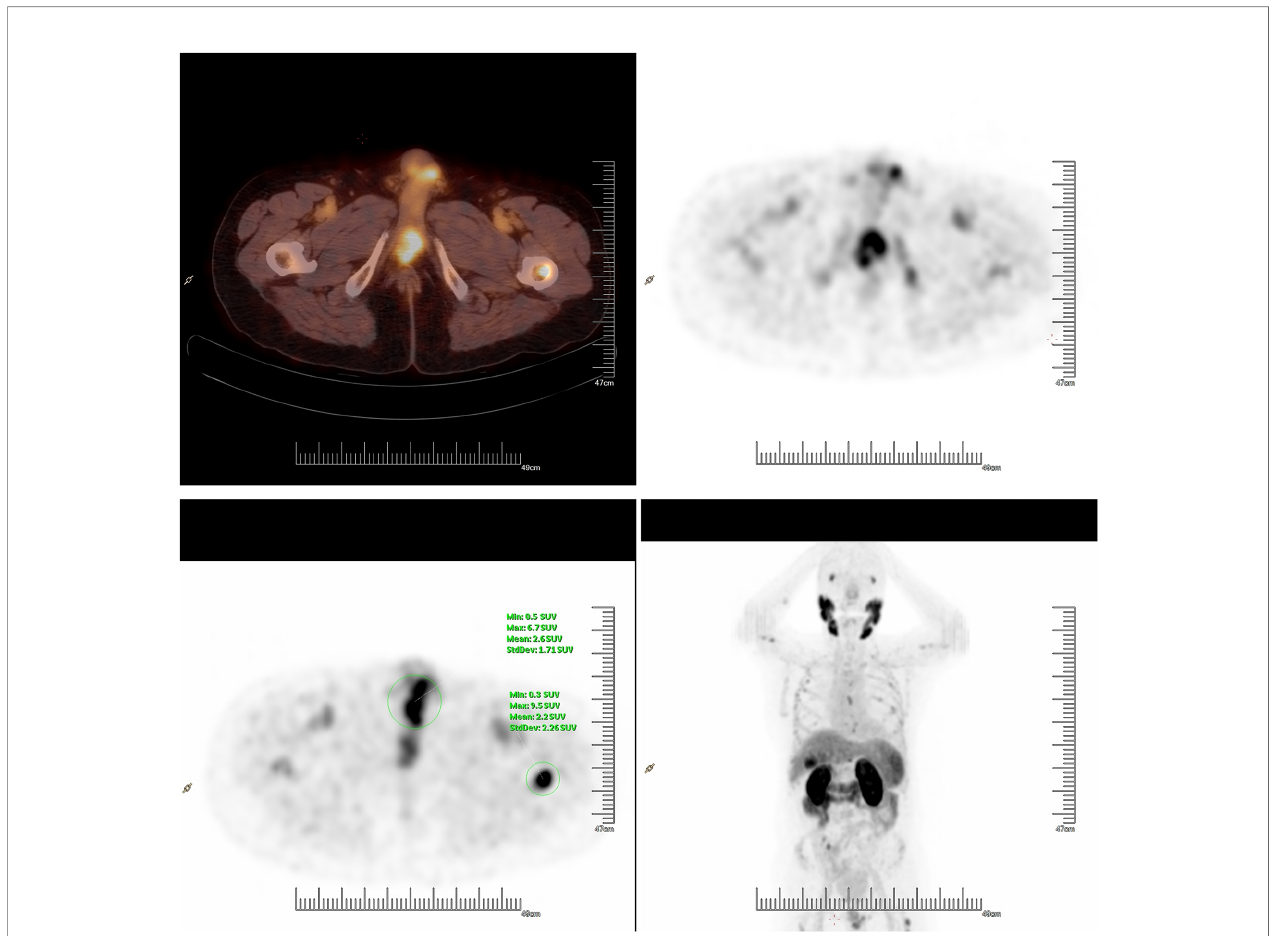
FIGURE 2 | 18 F prostate-speci fi c membrane antigen PET/CT showed suspicious tracer uptake in the base of the penis and multiple bone